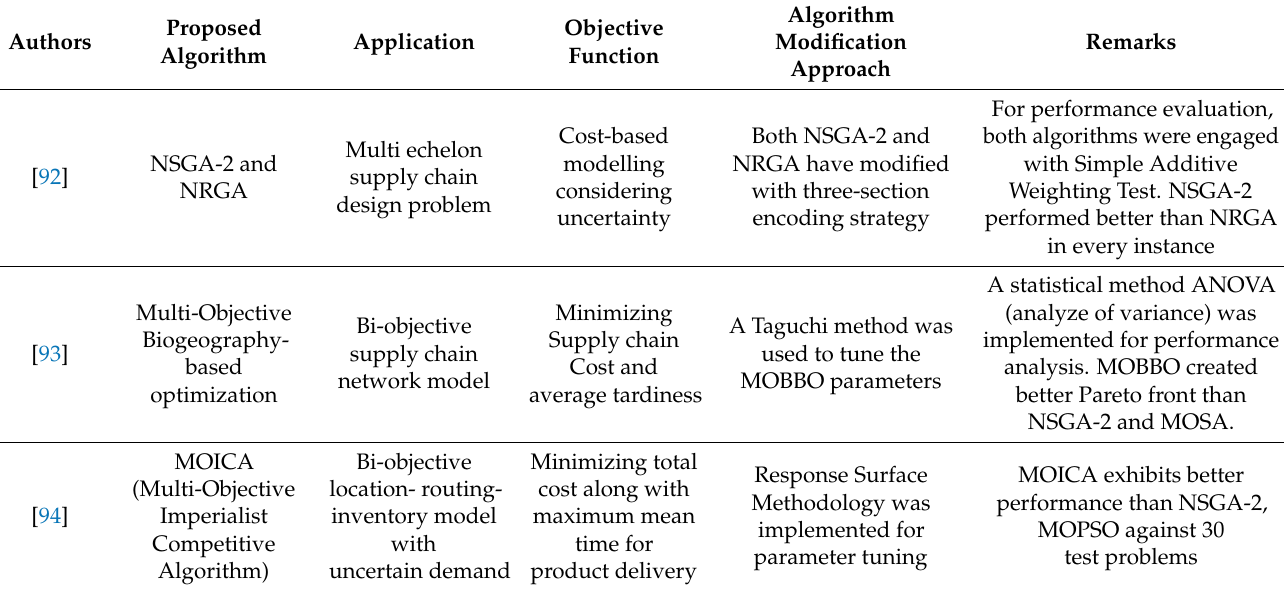
Table 5. Selected literature on NSGA-2 implementation in